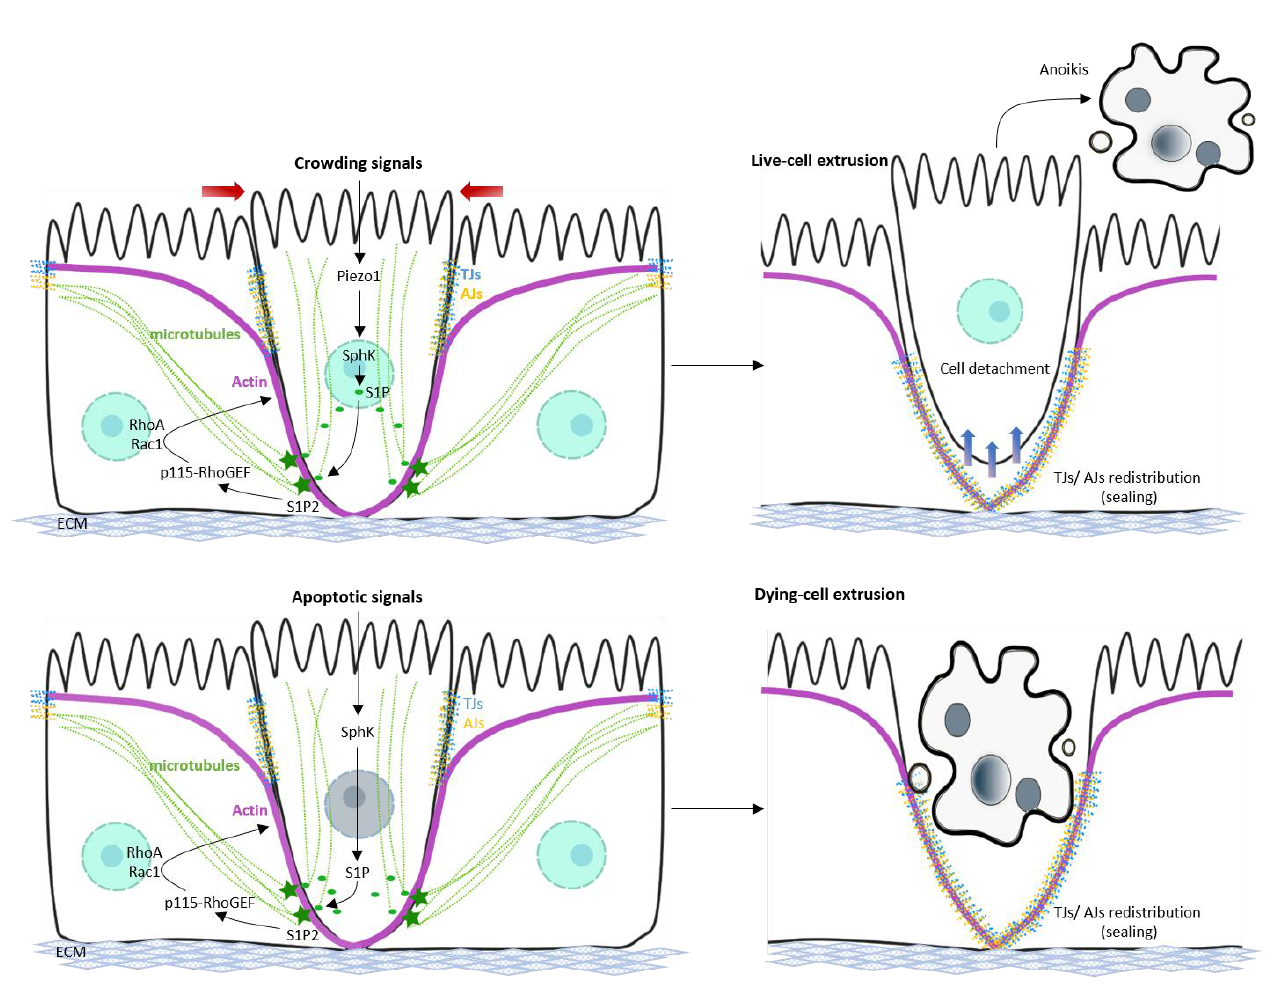
Figure 1. Live versus apoptotic cell shedding.